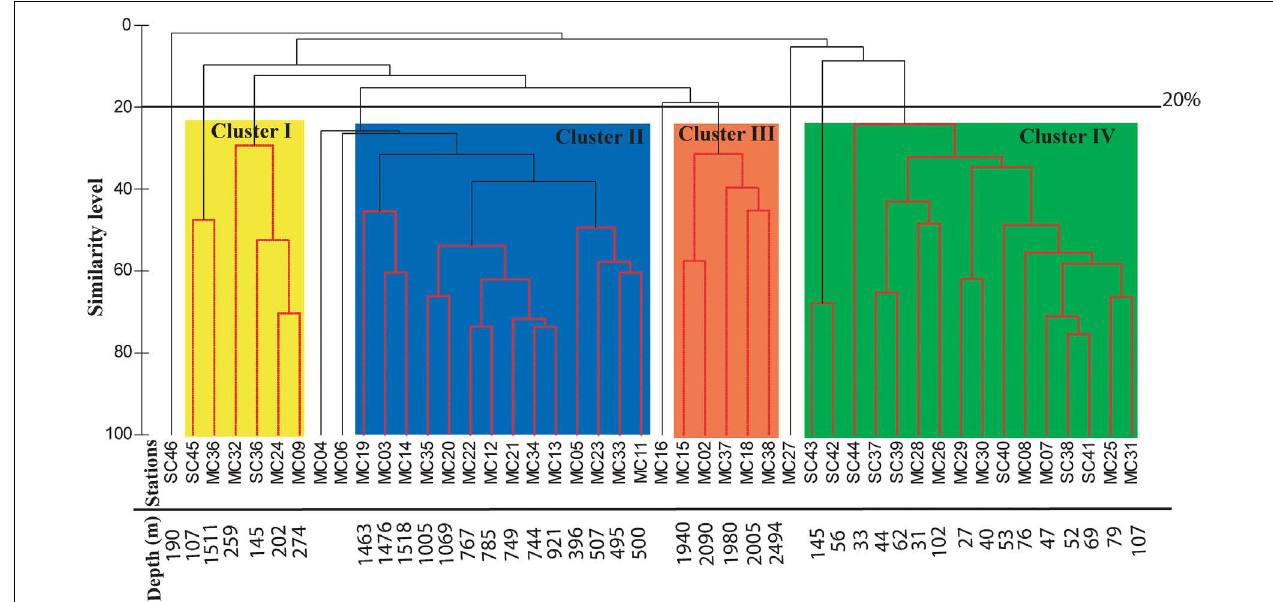
FIGURE 7 | Cluster analysis using Bray-Curtis similarity at 20% similarity level. The four identified clusters have been shaded in different colors as Cluster I, II, III, and IV.